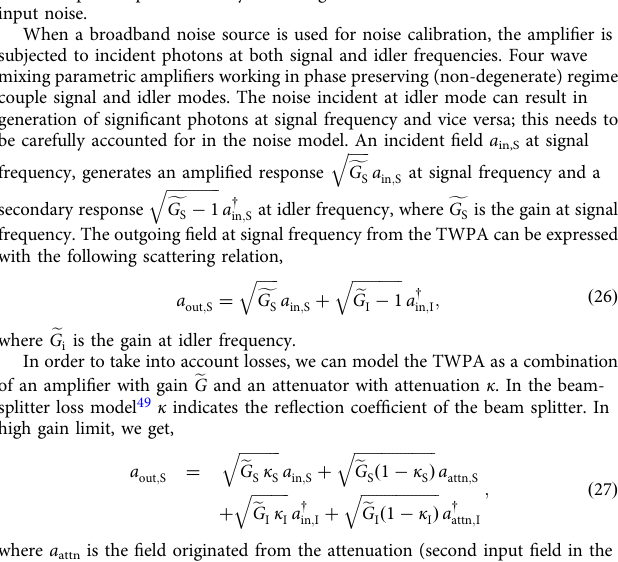
ffiffiffiffiffiffiffiffiffiffiffiffiffiffiffiffiffiffiffiffiffi q e G ð 1 (cid:3) κ S ffiffiffiffiffiffiffiffiffiffiffiffiffiffiffiffiffiffiffiffi q e G ð 1 (cid:3) κ I